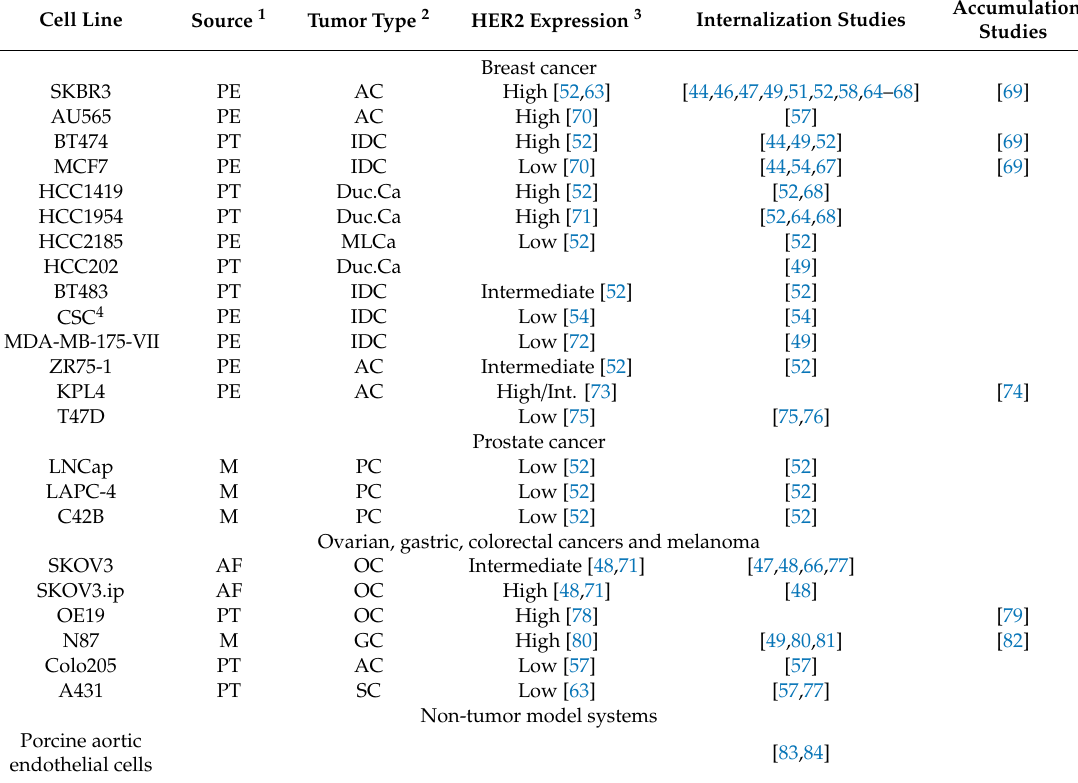
Table 1. Cell lines based on HER2 expression levels studied for internalization and